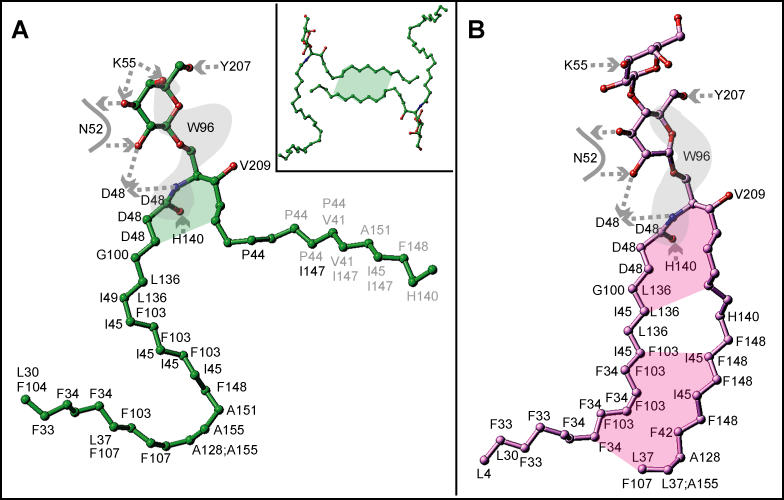
Comparison of the GLTP-Bound GSL Structures(A) Schematic of GSL interactions involving 24:1 GalCer in the sphingosine-out binding mode. Lettering indicates interacting GLTP amino acids, dashed arrows show hydrogen bonds oriented from donor to acceptor, the gray surface covers lipid atoms interacting with W96 indole group, the colored planes cover lipid regions participating in interchain interaction, gray lettering corresponds to interactions with a neighbor GLTP in the packing-related dimer in the crystal. The insert shows a schematic of sphingosine-sphingosine interaction of 24:1 GalCer in the crystal-related cross dimer.(B) Schematic of GSL interactions involving 18:1 LacCer in the sphingosine-in binding mode. Lettering and colored planes are defined as in (A).